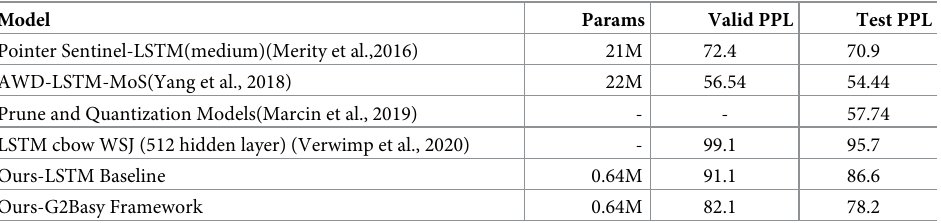
Table 9. Word-level valid and test perplexity on